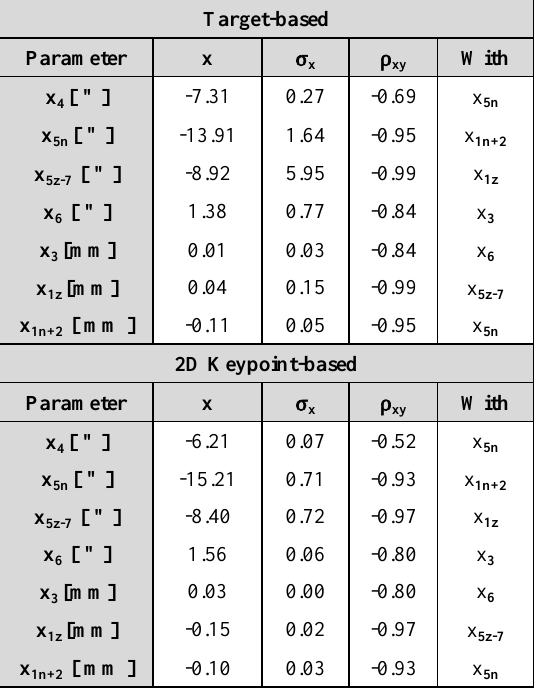
(sign). The zero differences are represented with a green color, while all differences breaching a threshold of 1 mm are colored blue and red (the values in between vary gradually). The red rhombus denotes the scanner station.